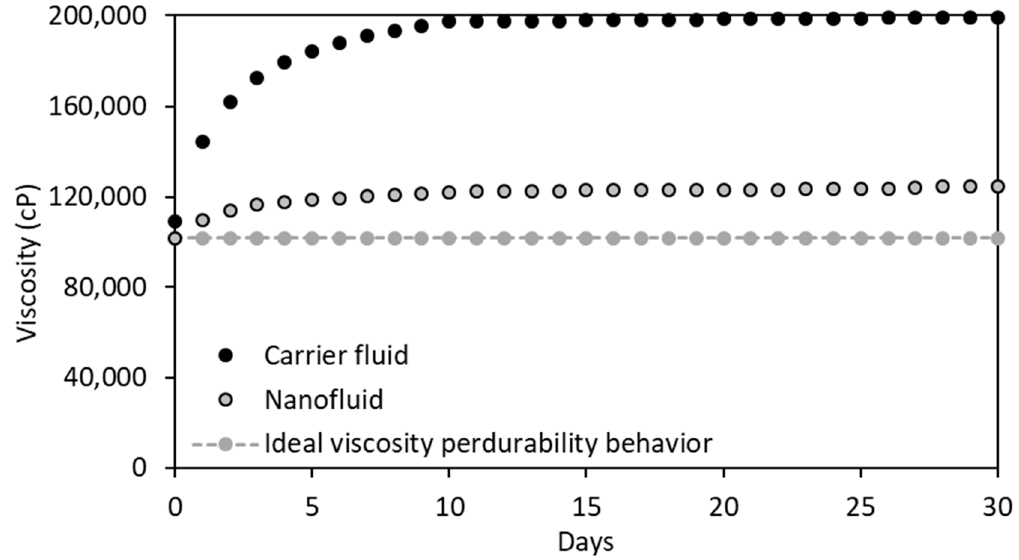
Figure 10. Viscosity perdurability behavior for the treated extra ‐ heavy oil at 30 °C in the presence of 5 vol % of the carrier fluid composed of a xylene/dimethylformamide ratio of 0.2 and the nanofluid with S9 nanoparticles at 1000 mg ∙ L − 1 suspended in the carrier